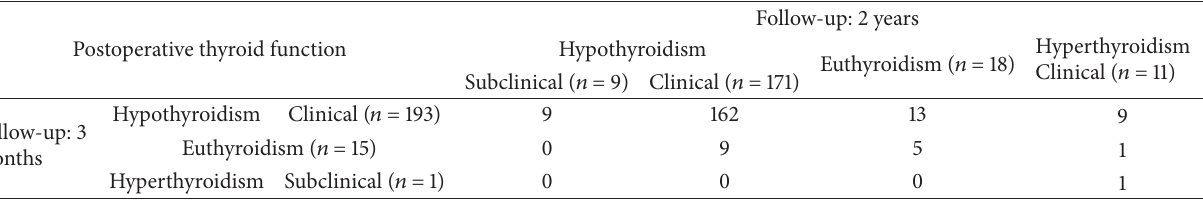
Table 3: Change in postoperative thyroid function in 209 Graves’ disease patients after subtotal thyroidectomy 3 months and 2 years after surgery.